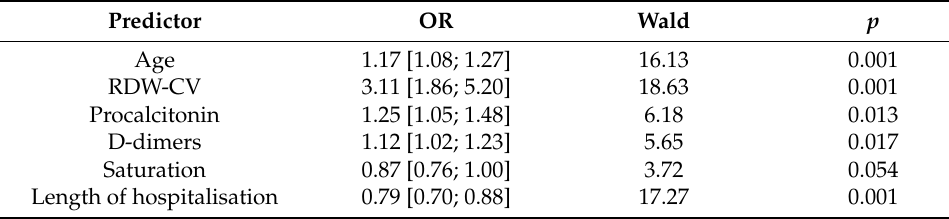
Table 3. Potential predictors of mortality included in the final model. Predictor